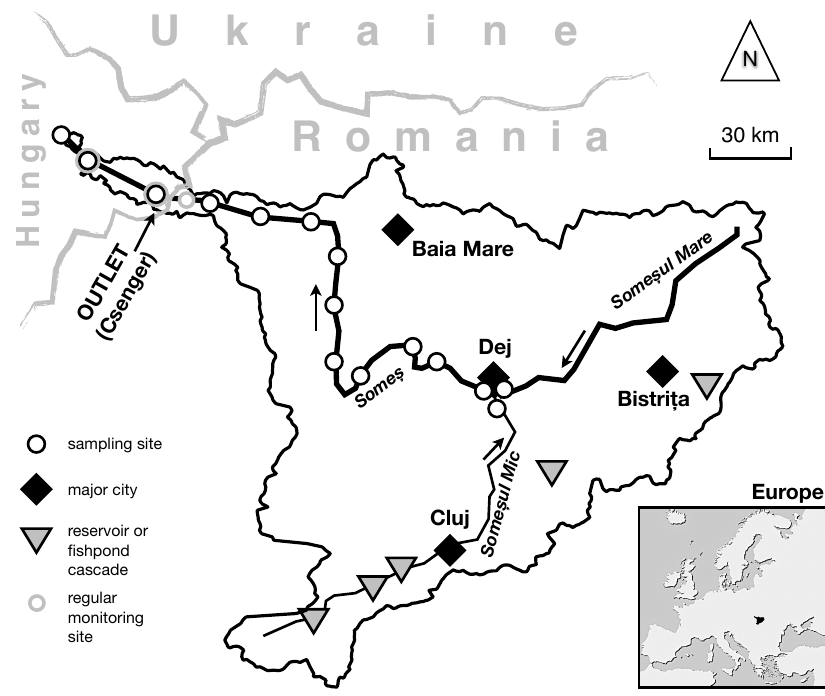
Figure 1. The Szamos/Some¸s catchment with major cities, standing waters and the 15 sampling locations. The discharge gauge at the city of Csenger was considered as the catchment outlet for this